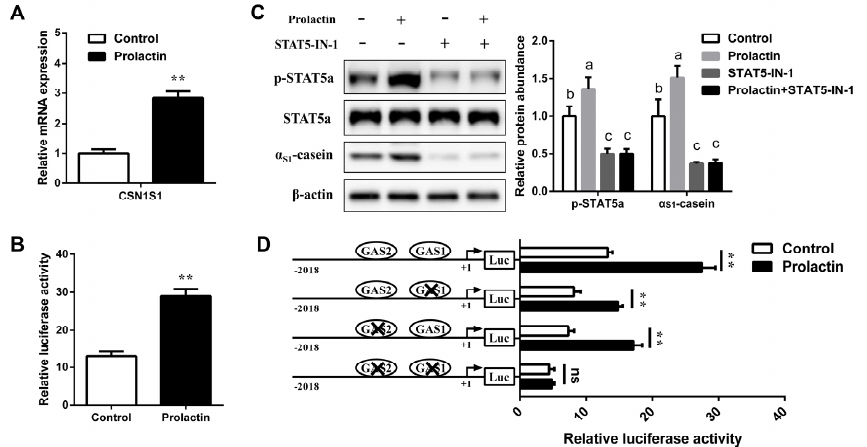
Figure 6. Effects of prolactin on the expression and promoter activity of the CSN1S1 gene. ( A ) The mRNA expression level and ( B ) promoter activity of CSN1S1 in GMEC incubated with prolactin (2 mg/L) for 48 h in culture medium. ( C ) GMEC seeded in culture medium were treated with STAT5- IN-1 (200 µ M, or DMSO) before prolactin (2 mg/L) treatment for 48 h, then total protein was extracted. Relative expression of α S1 -casein was normalized by comparison to β -actin. Relative expression of p-STAT5a was normalized by comparison to STAT5a. ( D ) Relative luciferase activity of CSN1S1 promoter activity in GMEC co-treated with prolactin (2 mg/L) and the wild-type pGL3-CSN1S1 (or GAS site-mutated constructs) for 48 h in culture medium. Data are shown as means ± SEM for 3 biological replicates. ** p < 0.01. Differences between 2 groups are considered significant at